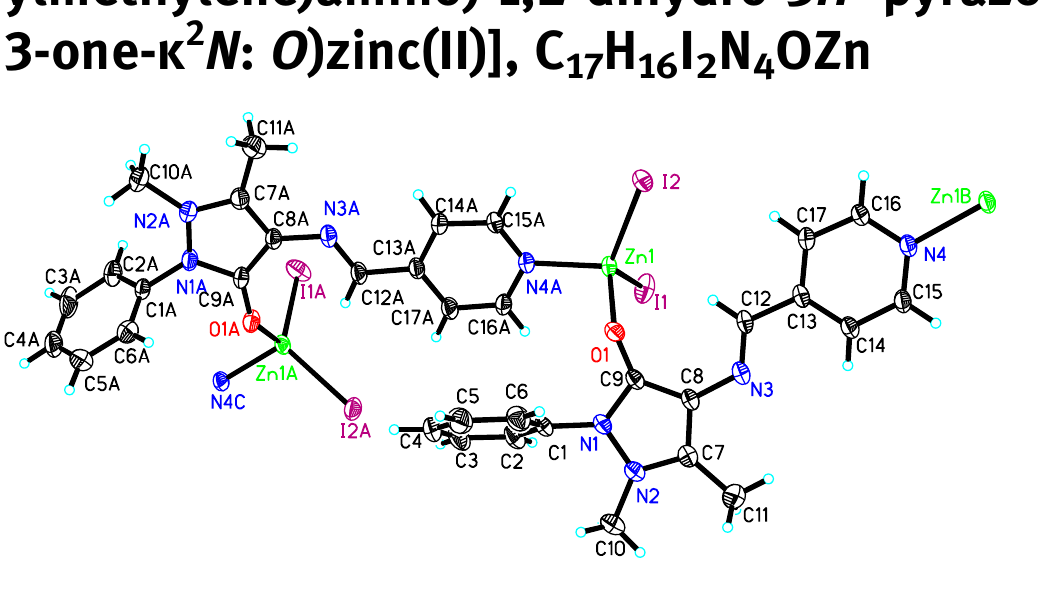
Table  : Data collection and